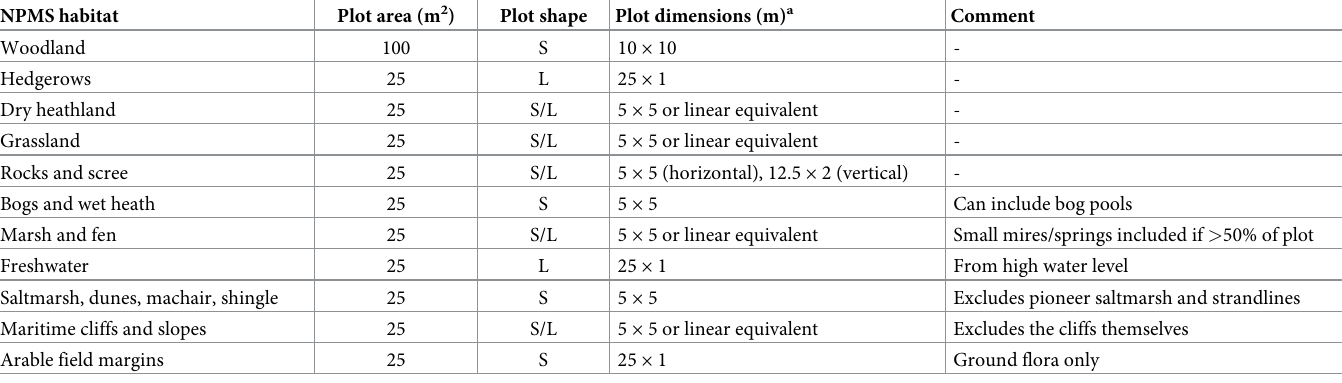
Table 2. The size and shape of plots used for surveying different habitat types within the NPMS. See [58] for more detail. S = square; L = linear. NPMS habitat Plot area (m 2 ) Plot shape Plot dimensions (m) a Comment